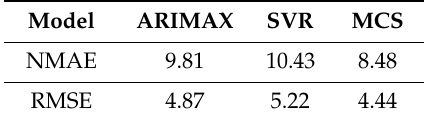
Figure 7. Weights for ensemble model (the x axis represents the 1 day intervals time for the evaluation period). Figure 8 shows the results of combining the forecasting results by applying the weights in Figure 7. The forecasting error is shown in Table 4. Accuracy is improved through the ensemble approach. The ensemble approach does not always improve accuracy, but it can compensate for overshoots occurring at turning points and prevent bias of the results. Thus, the ensemble approach is a viable